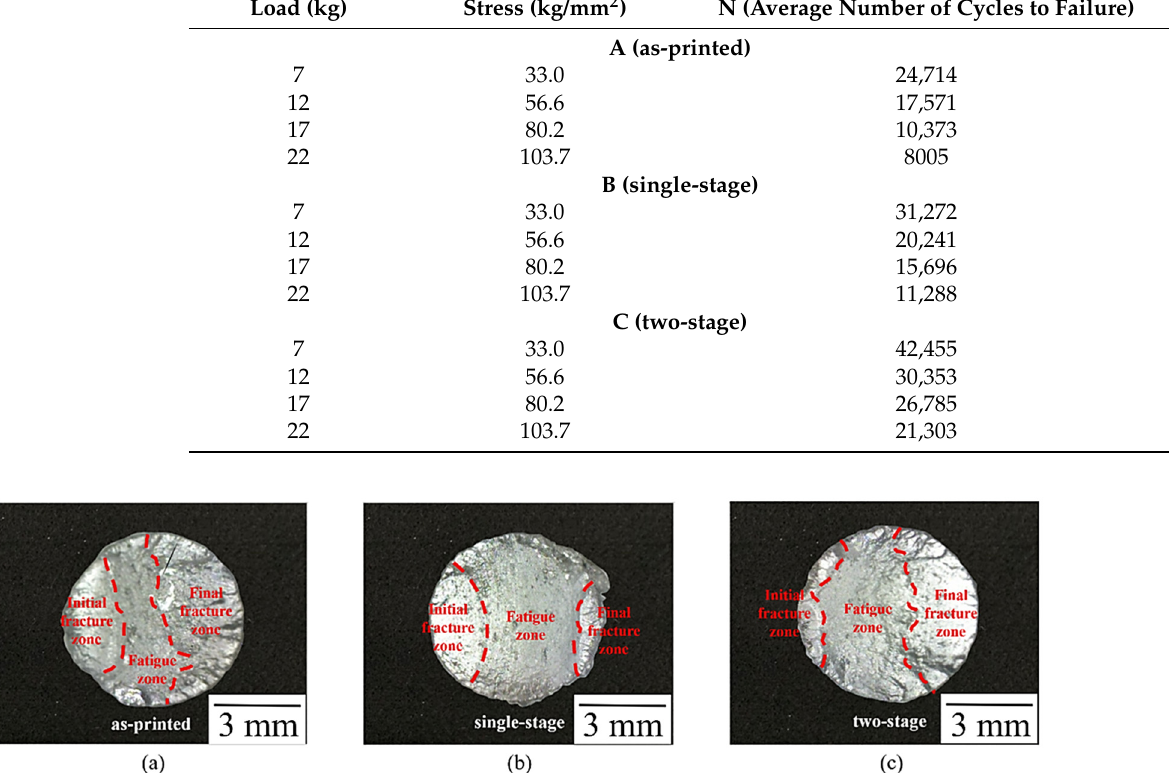
Figure 9. Macrostructure of fatigue fracture of the SLM Al–Mg–Sc–Zr alloys under 7 kg load: ( a ) as- printed and ( b ) single-stage- and ( c ) two-stage-heat-treated specimens.